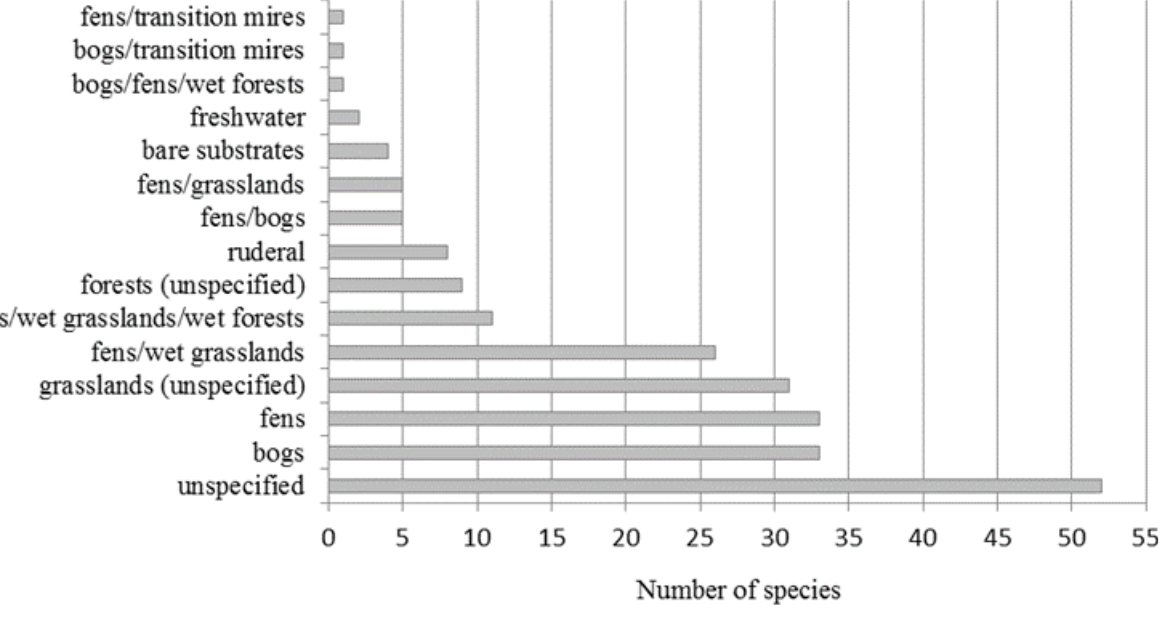
Figure 2. Summary of affiliations to certain habitat types of the plant and lichen species found in the studied cutaway